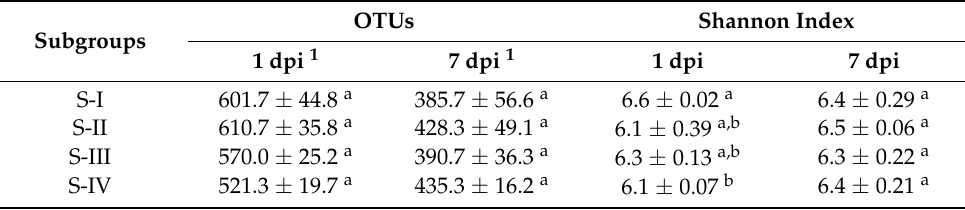
Table 1. Estimates of the alpha diversity parameters (M ±